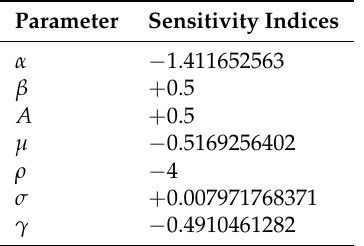
Table 2. Sensitivity analysis of R 0 : β = 10 − 10 .